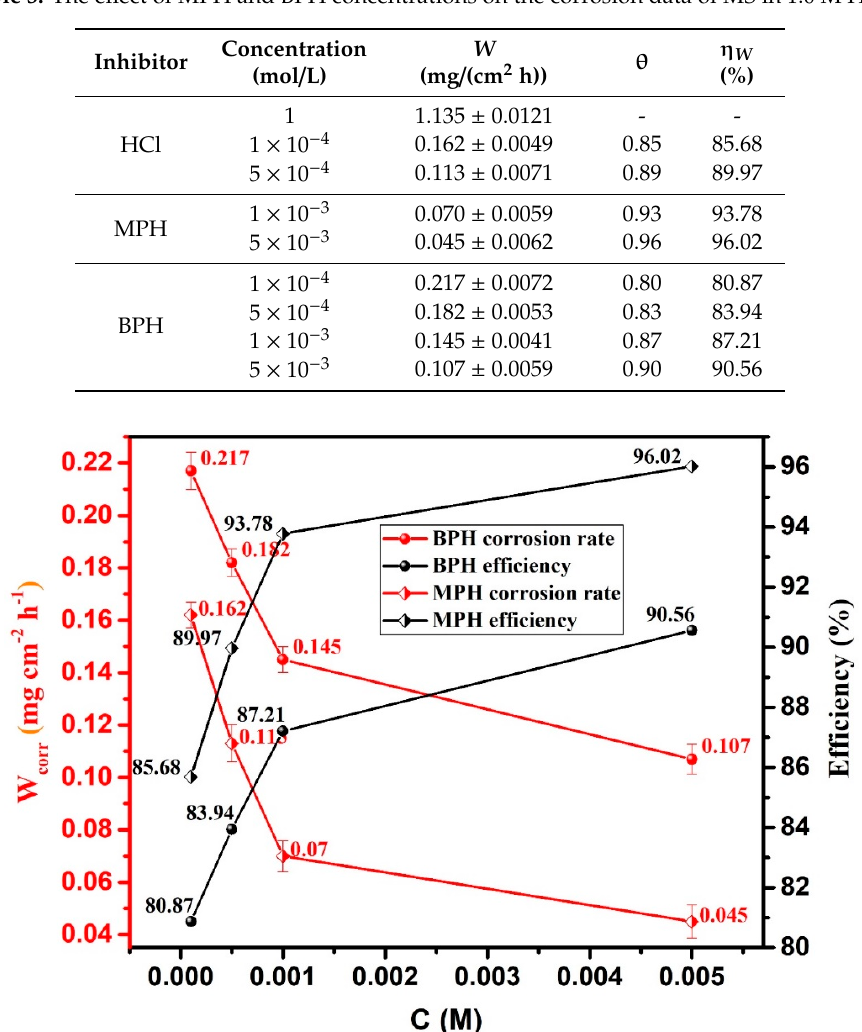
Figure 1. The relationship among corrosion rate, inhibition efficiency, and inhibitors concentrations for mild steel in MPH and BPH at 303 K.